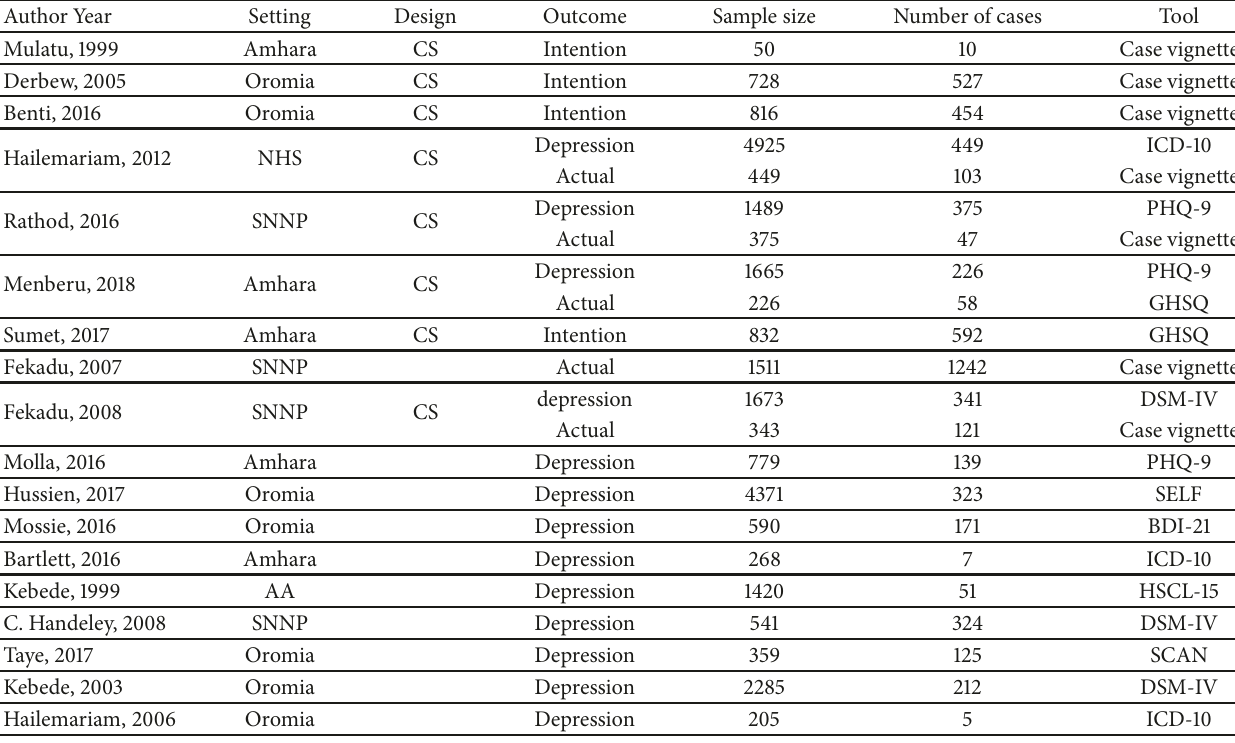
Table 1: Characteristics of included